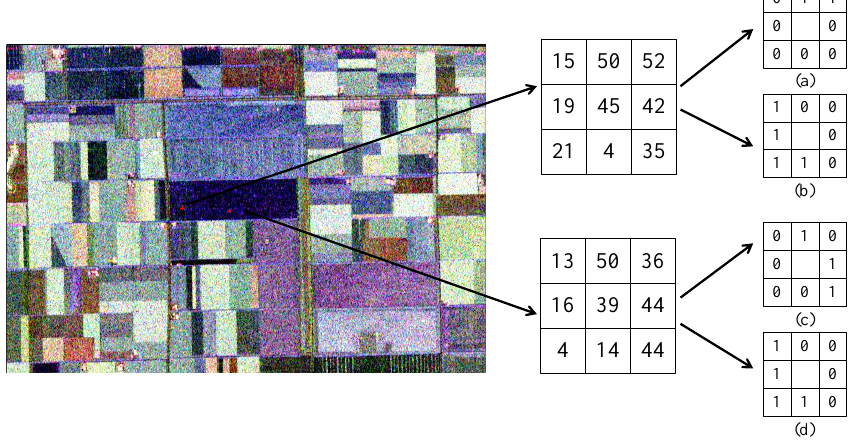
Figure 2. Two pixels belonging to the same class and their binarization results. (a,c) The results by rotation invariant uniform local binary pattern (RIU-LBP); (b,d) the results by regional homogeneity local binary pattern (RHLBP) with T = 20